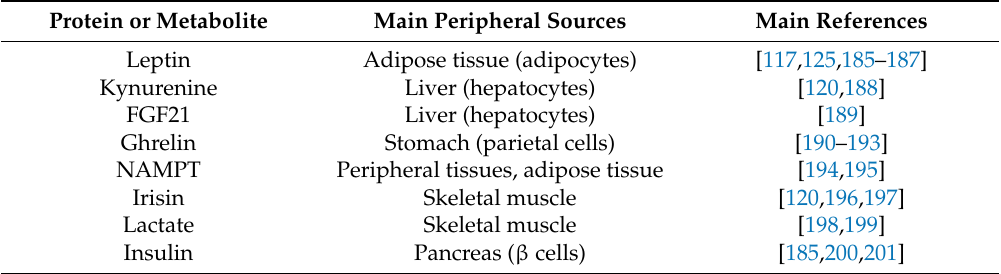
Table 1. Examples of endocrine signals relaying nutritional status from the periphery to the brain, with potential or established effects on the regulation of circadian rhythms and/or